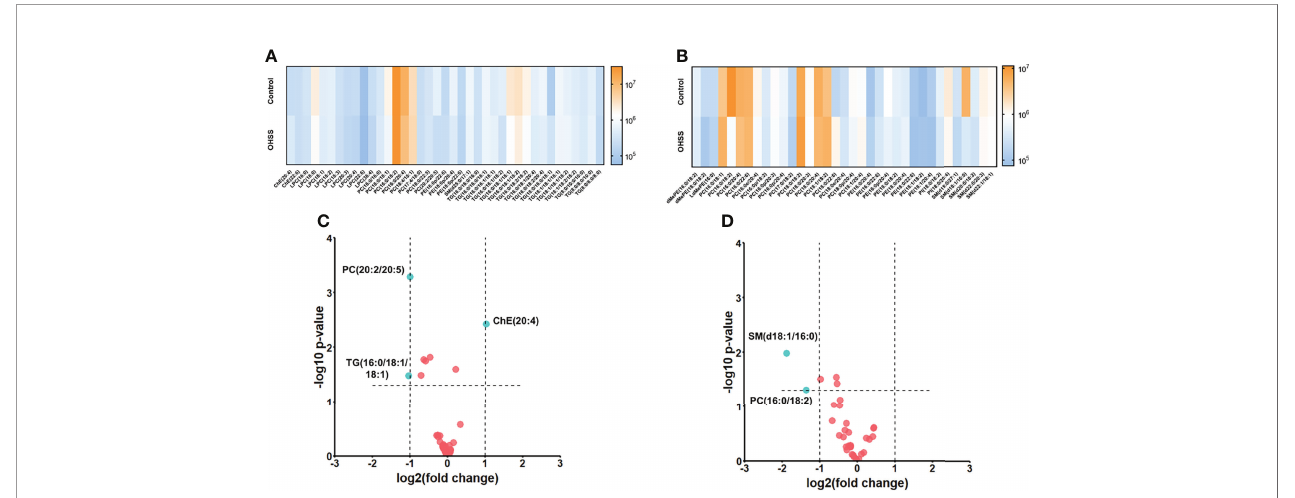
FIGURE 2 | The heatmaps under positive mode (A) and negative mode (B) showed the intensities and change trend of 9 classes of lipids in Control and OHSS group. The volcano plots under positive mode (C) and negative mode (D) suggested the 5 most discriminant lipids with fold change>2.0 and p < 0.05 (the lipids were highlighted in blue in the fi